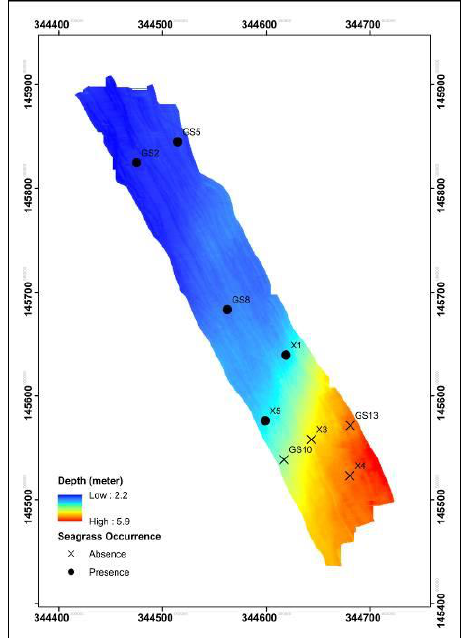
Figure 4 . Bathymetry map and seagrass occurrences.